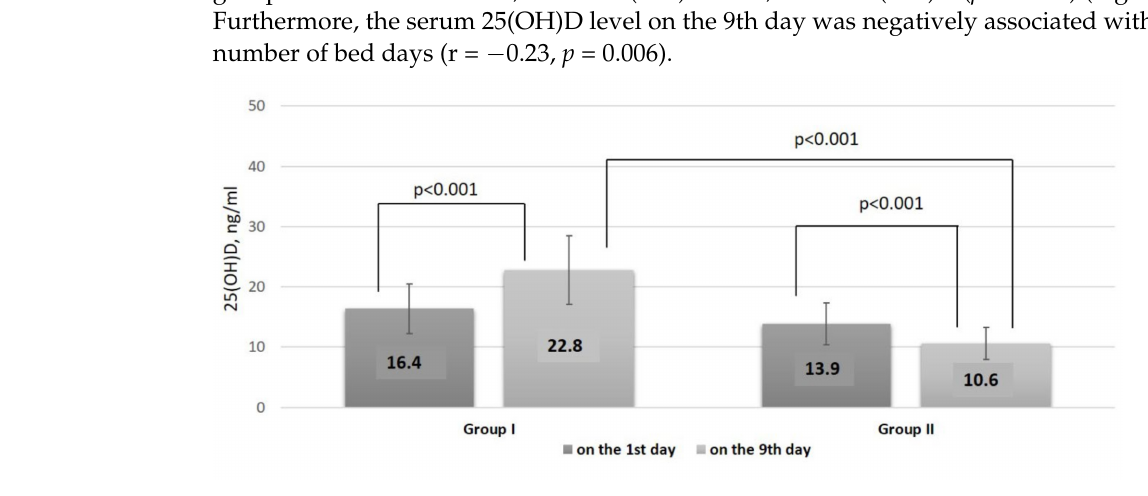
Figure 2. Serum 25(OH)D level before and after supplementation with 100,000 IU of